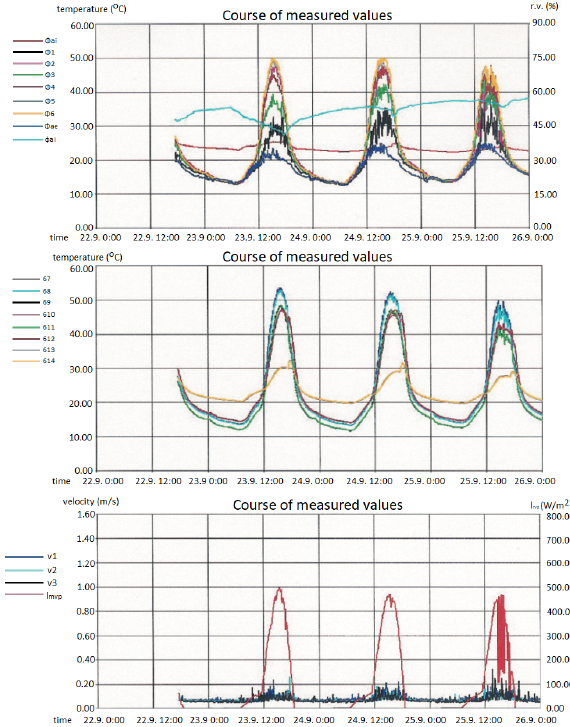
Figure 12: The example of measured values from the experiment for the typical period of clear windless warm weather (v w ≤ 0.5 m/s).